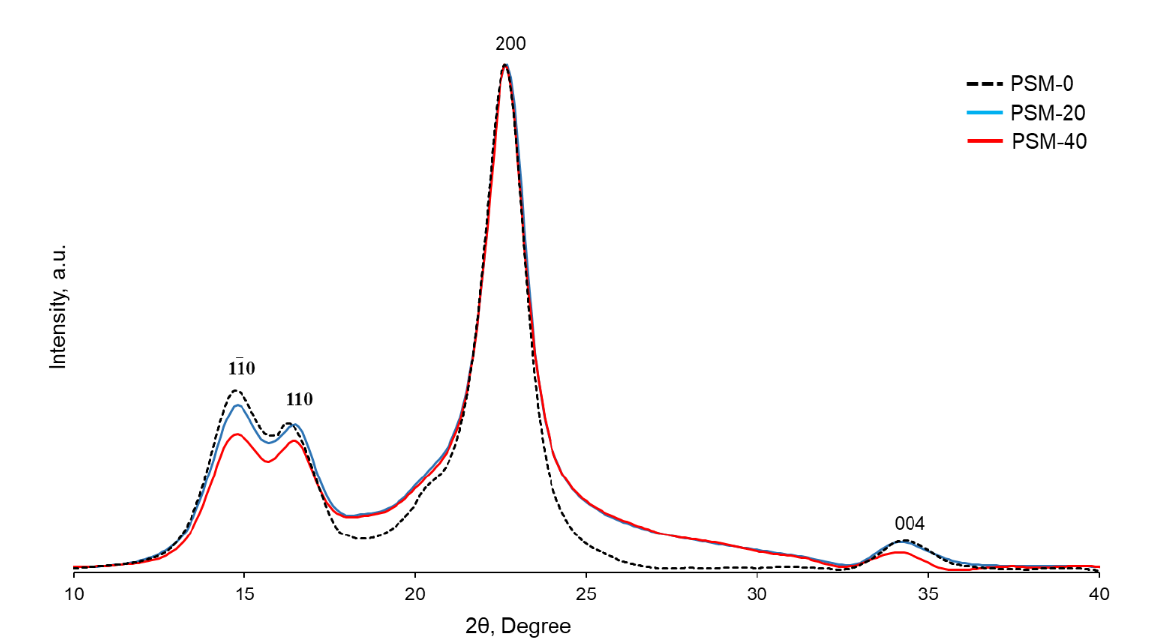
11 of 19 Figure 7. Radical formation on cellulose molecules upon exposure to oxygen plasma: (1) dehydro- genation at C6 and (2) cleavage of pyranosidic bond (O(ring)-C1).